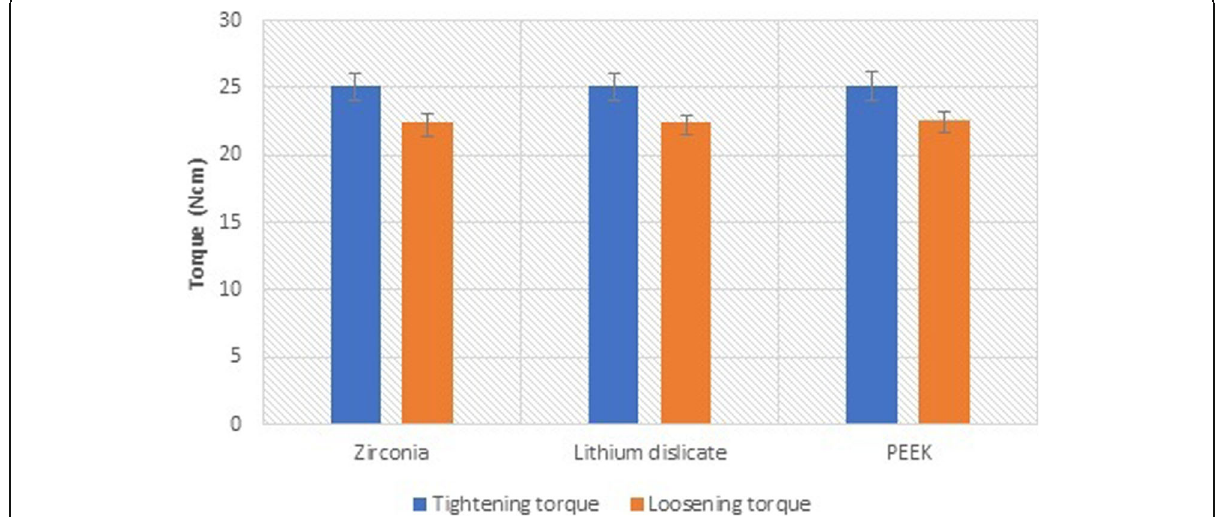
Fig. 1 The tightening torque and the loosening torque of zirconia and lithium disilicate and PEEK